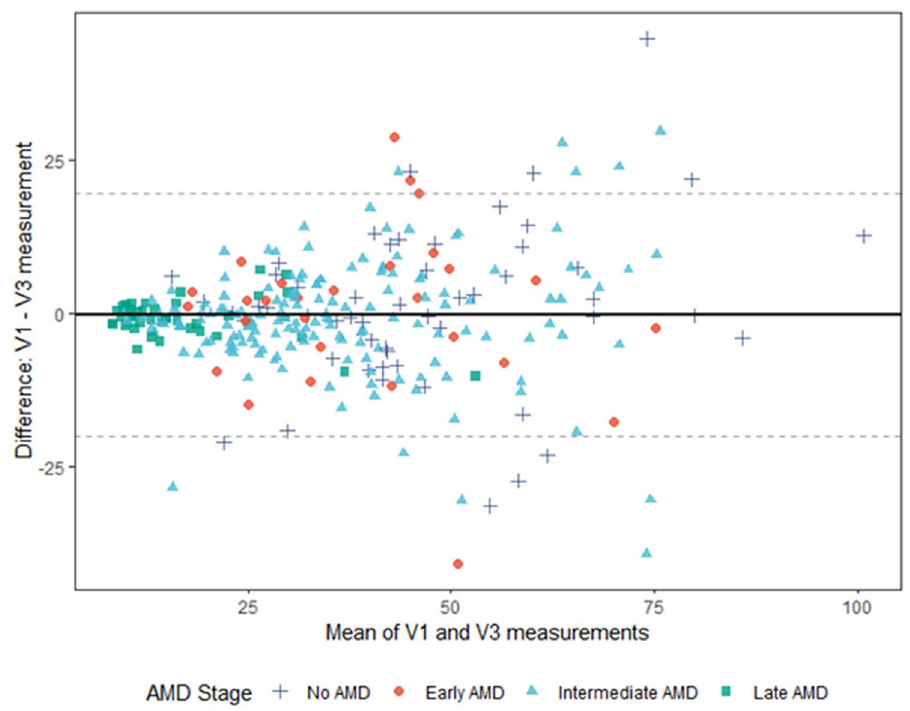
Figure 3. Bland–Altman plot for the overall test–retest study population (n = 286) of the differences in the mean rEZR values per patient at V1 and V3 (solid line: mean difference; dotted lines: mean ± 1.96 × standard deviation). The rEZR difference between both visits (y axis) is presented against the rEZR average for V1 and V3 (x axis). AMD age-related macular degeneration, V1 screening visit, V3 follow-up visit, rEZR relative ellipsoid zone